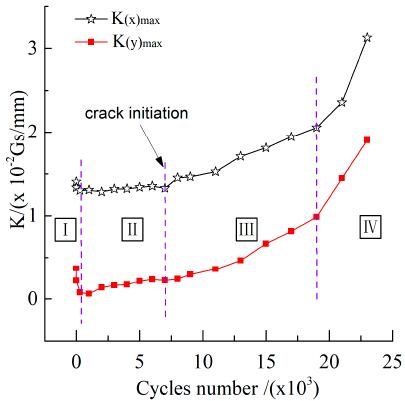
Figure 15. Variations of K(x) max and K(y) max at different fatigue cycles.